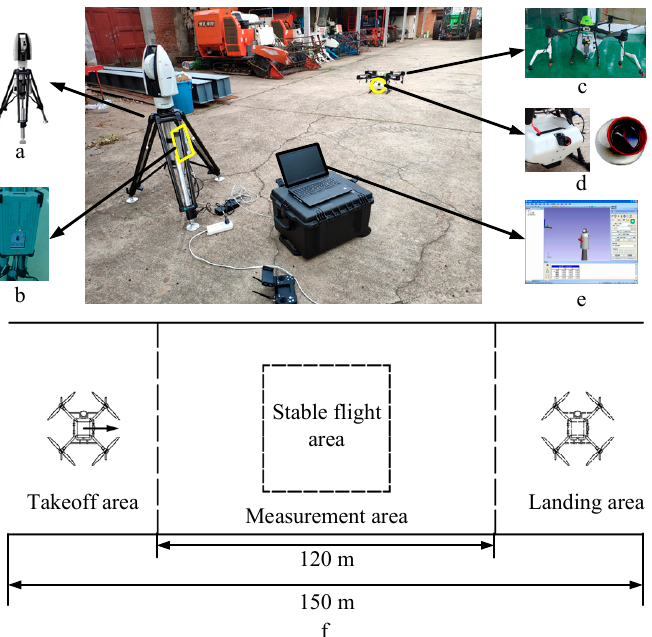
Figure 1. Experimental device and experiment area diagram: ( a ) Leica AT960-LR host and bracket,